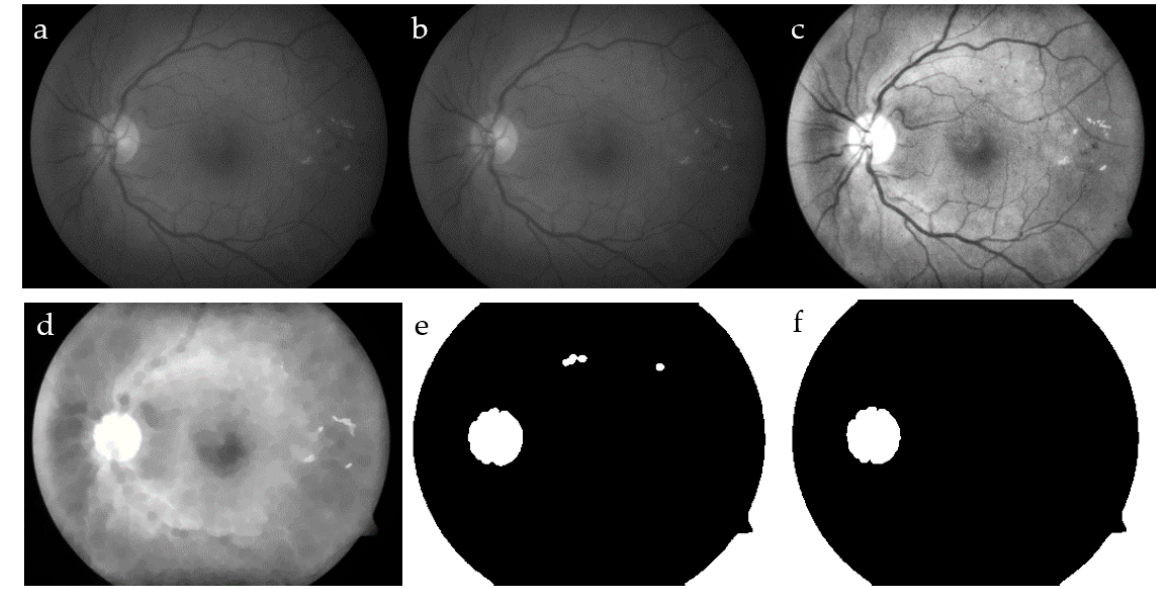
Figure 2. Locating optic disc (OD): intensity of a fundus image ( a ); median filter ( b ); contrast-limited adaptive histogram equalization (CLAHE) ( c ) and closing ( d ) filters; and thresholding output on the filters output in ( e ) and OD detection in ( f ).